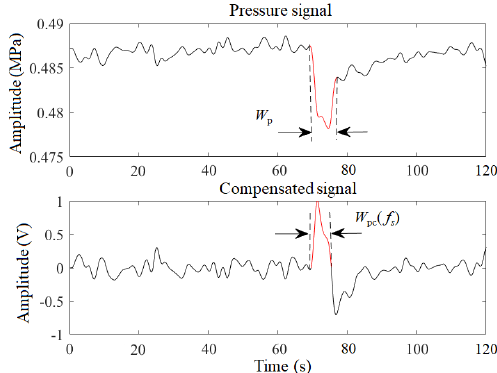
Figure 8. Width characteristic.